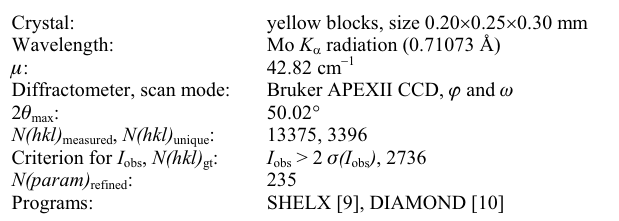
Table 1. Data collection and handling.